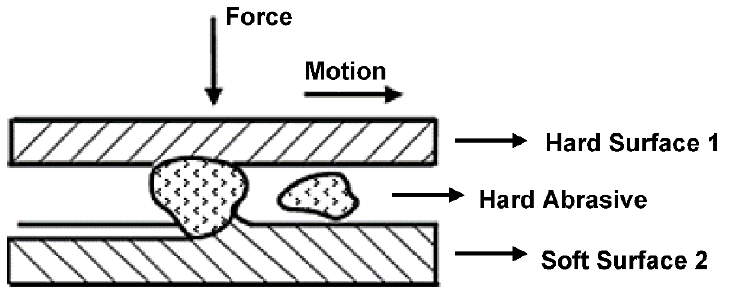
Figure 1. The principle of abrasive wear.